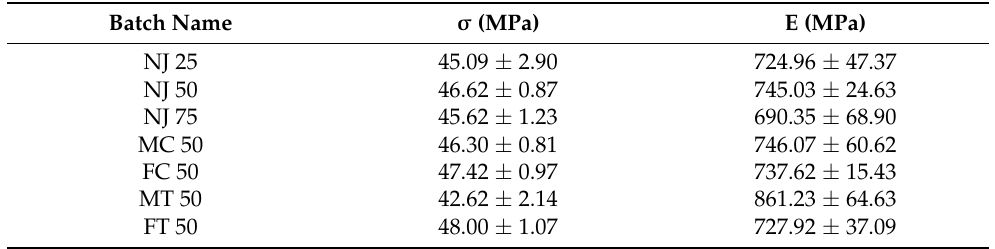
Table 6. Average tensile test results for all HYM samples, whose standard deviations have been shown in the brackets.